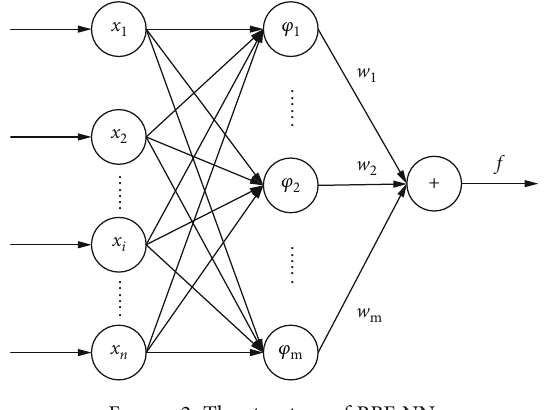
Figure 2: The structure of RBF NN.